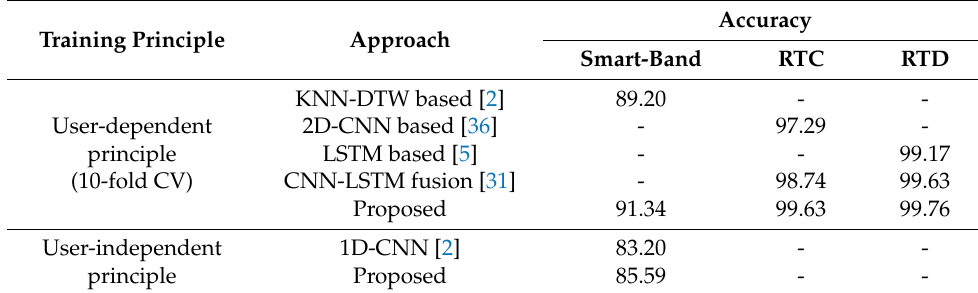
Table 7. Performance evaluation for user-dependent and independent methods on the 6DMG dataset. Abbreviations of the approaches are given in the Abbreviations section of this paper. Training